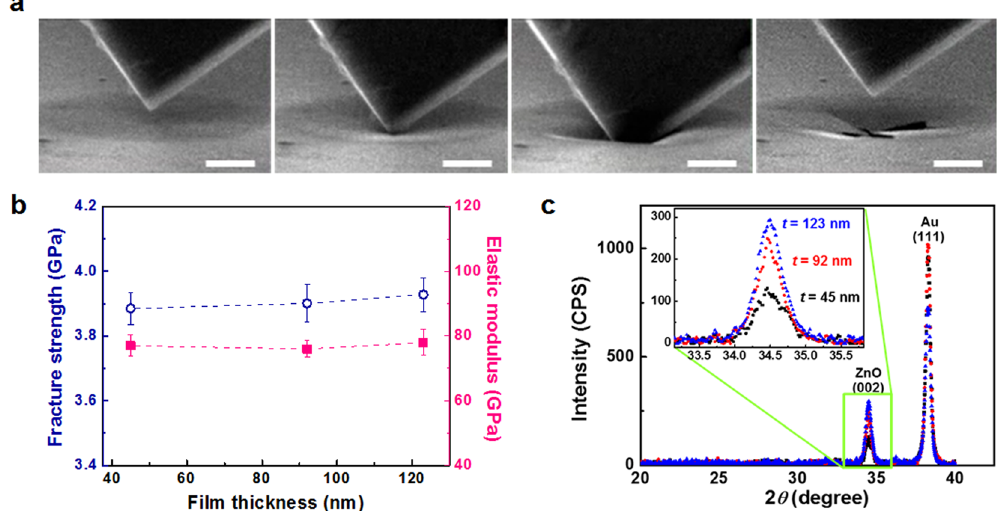
Figure 3. Measurement of fracture strength and grain size of ZnO film by hole-nanoindentation and grazing incidence XRD. ( a ) SEM images in in-situ SEM nanoindentation on suspended ZnO film (scale bars, 1 μ m). ( b ) Fracture strength and elastic modulus of ZnO film is independent of film thickness. ( c ) Grazing incidence XRD reveals that ZnO film has dominant (002) texture with grain size 25 nm regardless of film